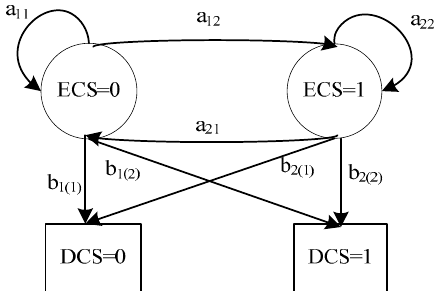
Figure 4. HMM-based channel prediction model.